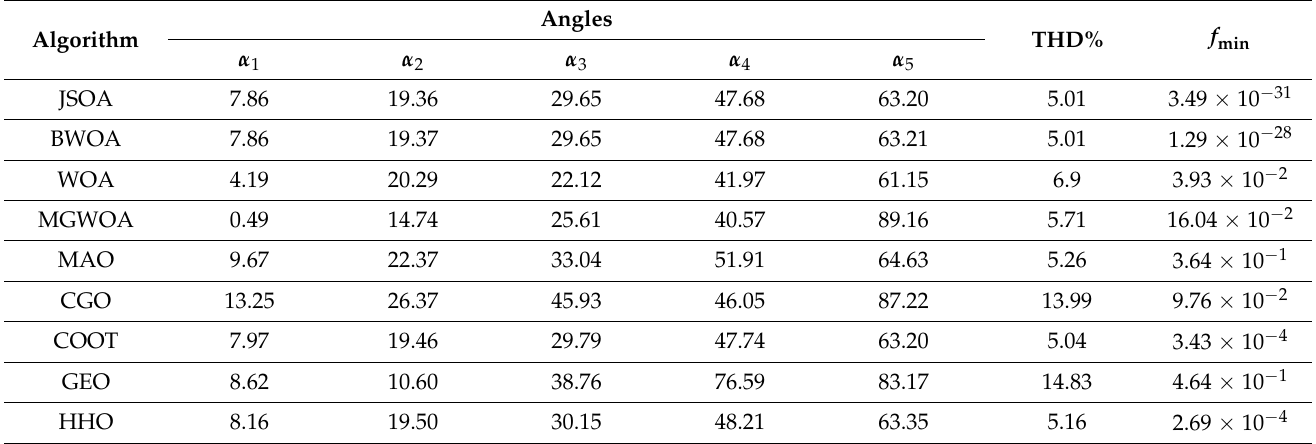
Table 12. Comparison results for the selective harmonic elimination